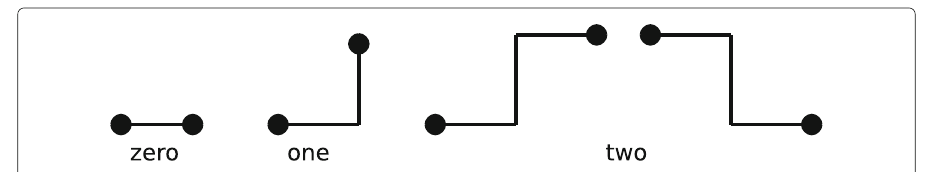
Fig. 6 Connections with zero, one, and two middle points between the endpoints. The endpoints are marked with circles